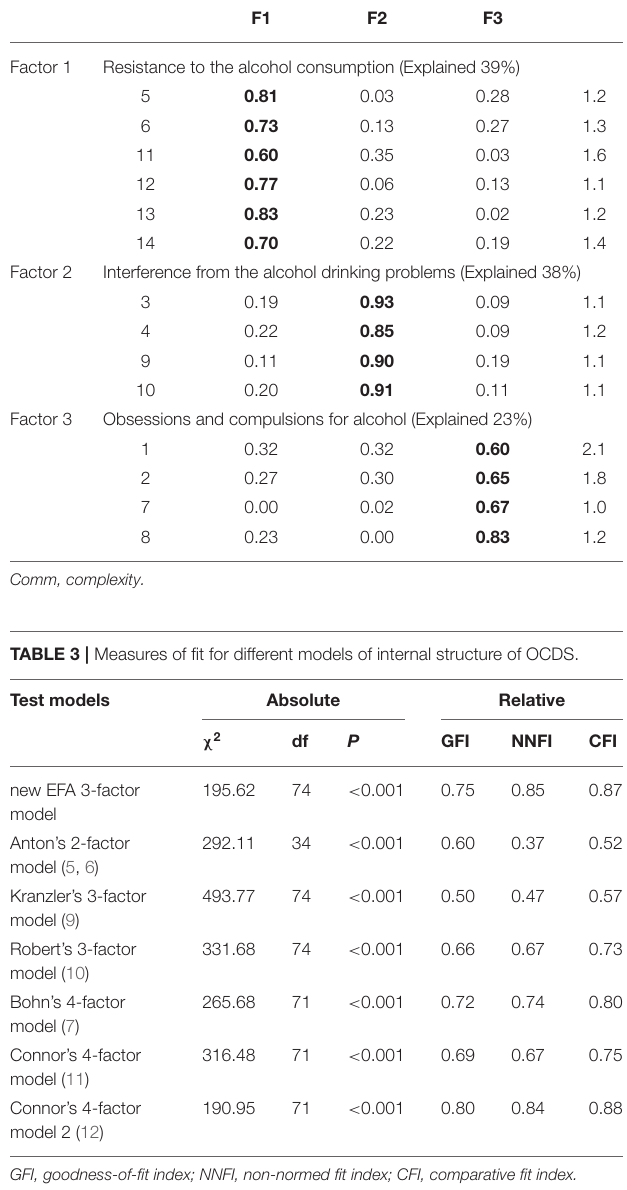
TABLE 2 | Factor loadings from the pattern matrix and percent variance explained by each factor. Factor Item